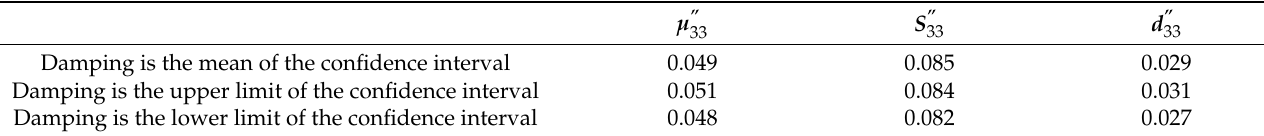
Table 5. The value of ∆ F when the damping is in the confidence interval (P = 99%).